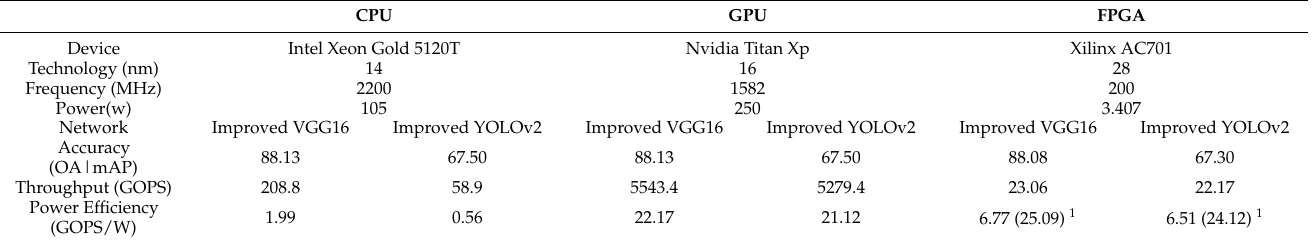
Table 2. Evaluation results on the central processing unit (CPU), graphic processing unit (GPU), and proposed